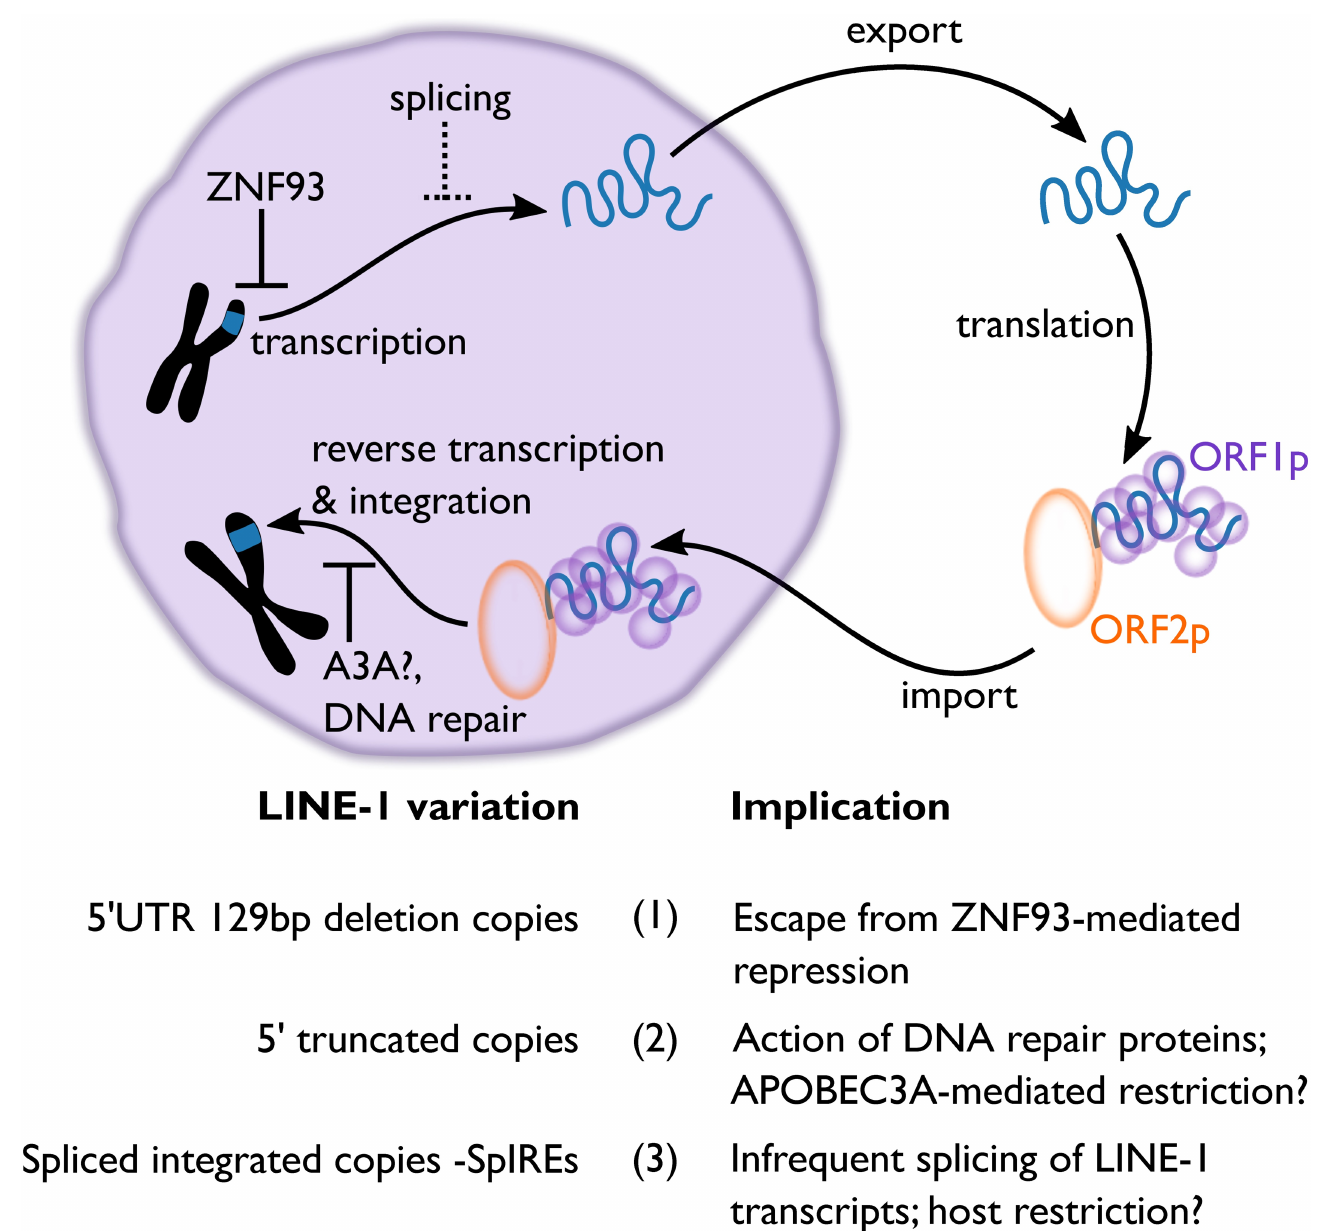
Fig 1. The long interspersed element-1 (LINE-1) lifecycle and lessons from ancient LINE-1 sequences. LINE-1 (long interspersed element-1) retrotransposons replicate using an RNA intermediate that encodes 2 proteins: ORF1p binds LINE-1 RNA, and ORF2p reverse transcribes and integrates that RNA to create a new LINE-1 copy (see Box 1). As a part of this replication, LINE-1 sequences must insert into the host genome. A genome’s inventory of these integrated sequences can be used to understand specific aspects of host and LINE-1 biology. For example, (1) LINE-1 sequences in the human genome are polymorphic for a 129-bp deletion in their 5 0 -untranslated region (UTR). This deletion allows LINE-1 sequences to evade the repressive effects of a DNA-binding protein (ZNF93) that initiates transcriptional silencing [18]; (2) most of the LINE-1 sequences in the human genome are 5 0 truncated. This may be due to the action of APOBEC3A, which deaminates single-stranded DNA at the site of LINE-1 insertion [19], or DNA repair proteins [20, 21]; (3) about 2% of all full-length LINE-1 sequences in the genome have been spliced, as shown by new research from Larson and colleagues [22]. This splicing inactivates the new LINE-1 copies, but retention of the splice donor site preserves a transcription factor binding site that drives efficient LINE-1 transcription. It is unclear whether host cells employ splicing to actively block LINE-1 replication. Abbreviations: SpIRE, spliced integrated retrotransposed element; UTR, untranslated region.